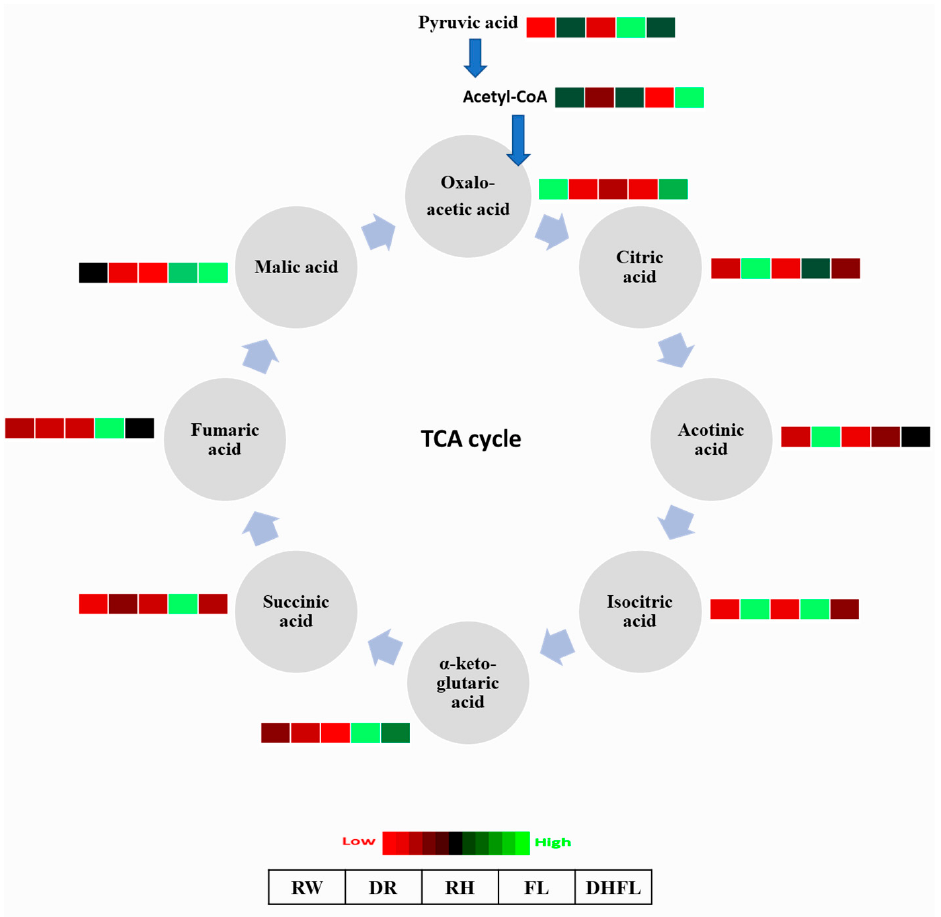
Figure 5. A heat map depicting the individual concentrations of intermediate metabolites of the tricarboxylic acid cycle in Mexican mint ( Plectranthus amboinicus ) plants under varying watering regimes (n = 3). Metabolite concentrations in each block compartment are normalized across all data for an individual compound such that similar color intensities between compounds can represent widely differing concentrations. The red color represents a lower concentration, and the green color represents a higher concentration of a particular metabolite. The compartments were arranged from left to right as follows: regular watering (RW), drought (DR), resumption of regular watering after drought (RH), flooding (FL), and resumption of regular watering after flooding (DHFL). Apart from oxaloacetic acid, which was comparatively high in RW plants, all the other metabolites were low. The low concentrations of succinic acid, isocitric acid, acotinic acid, and citric acid in RW plants were similar to those in RH and DHFL plants (Figure 5). Partic- metabolites. For the DHFL plants, the increase in TCA cycle metabolites can be ascribed to high levels of acetyl-CoA, oxaloacetic acid, and malic acid. According to Sweetlove et al. (2010) [70], TCA cycle intermediate metabolites do not have similar flux, and the